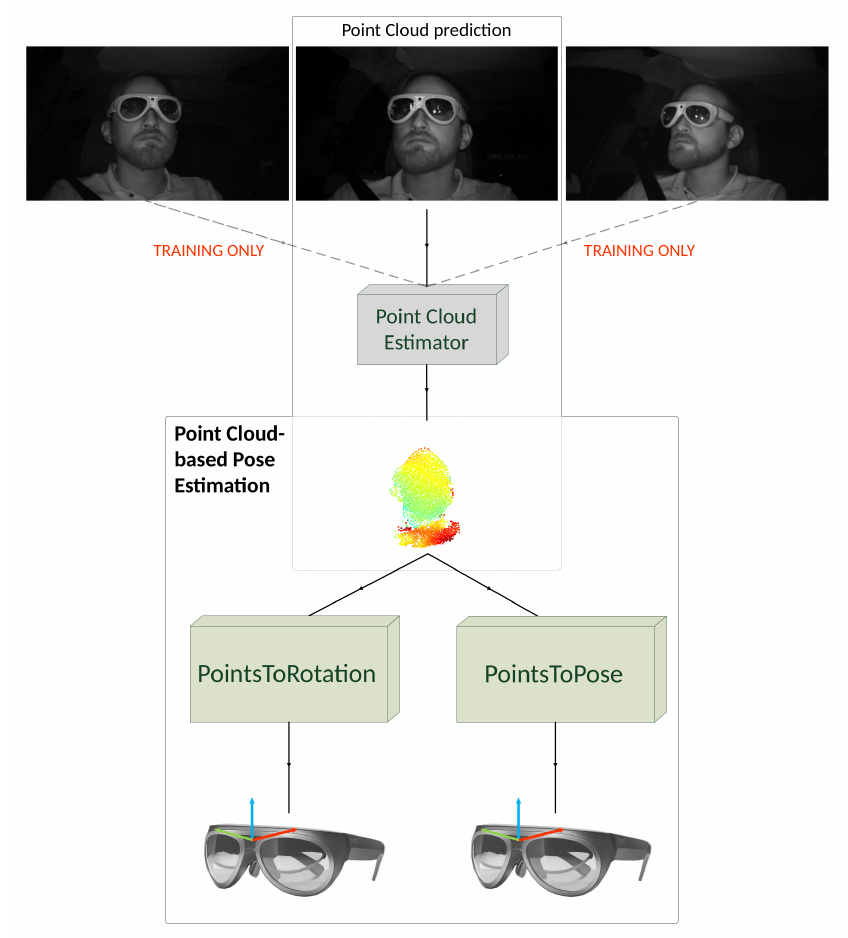
Figure 1. Our full object pose estimation pipeline. We train our point cloud estimator on three images and need one image during testing only to predict a point cloud. We use the point cloud for both our pose estimation